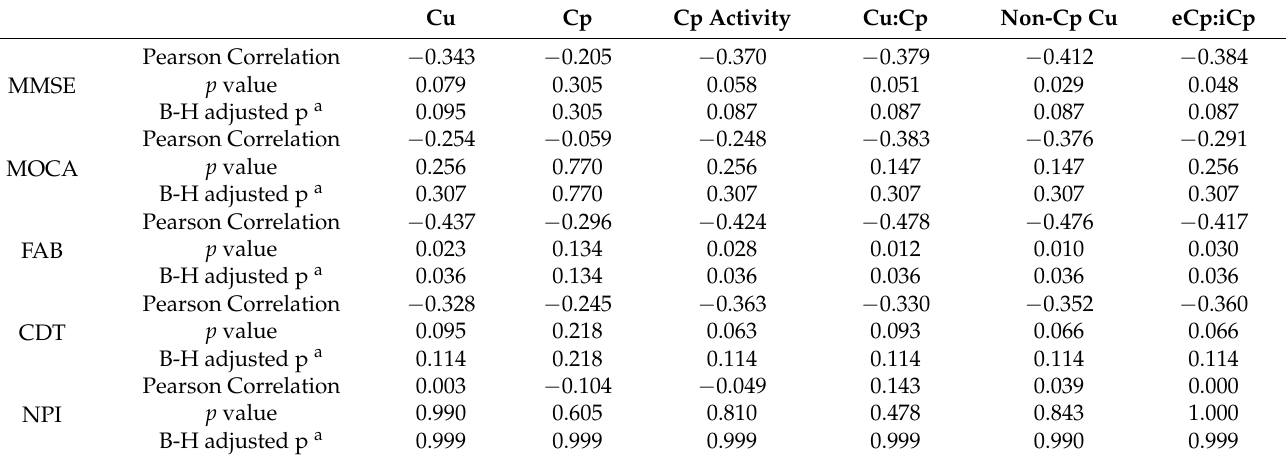
Table 5. Correlations between neuropsychological test battery outcomes and Cu biomarkers.